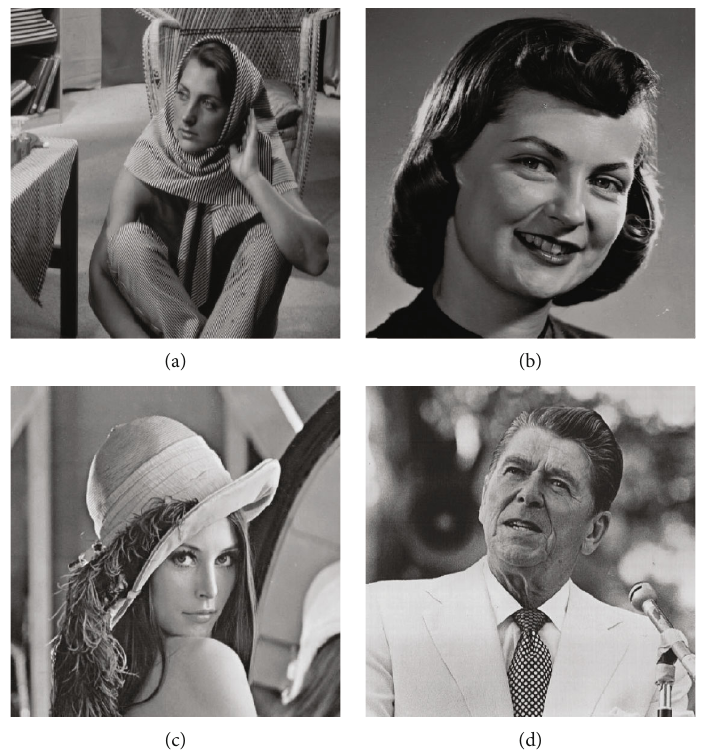
Figure 3: Face contour of face images. (a) Barbara. (b) Girl. (c) Lena. (d)